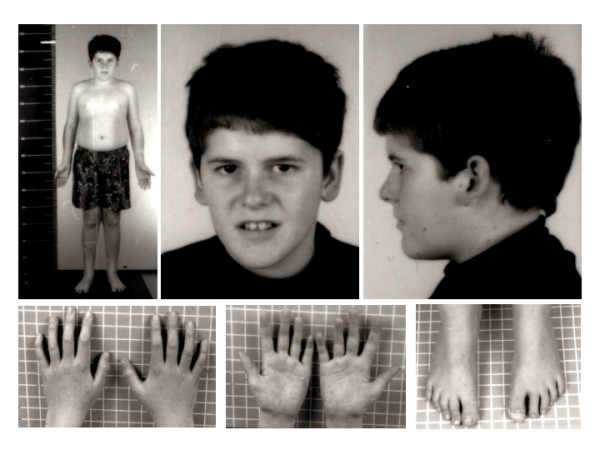
t(4;15) carrier at 15 years of age . Note absence of typical PWS facial features and presence of mild truncal obesity.